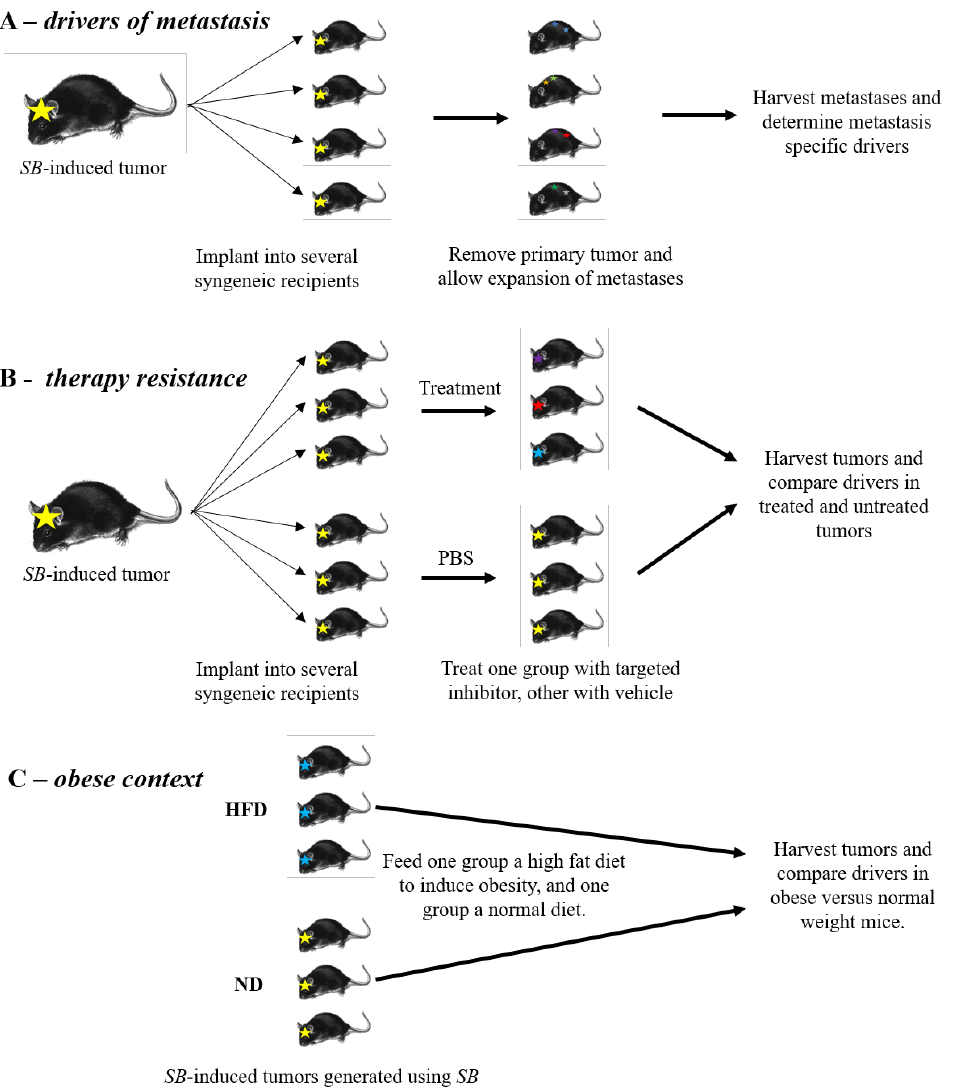
Figure 2. Future experiments for transposon insertional mutagenesis screens. ( A , B ) To identify drivers, induce tumor formation with insertional mutagenesis and implant tumors orthotopically into syngeneic recipients. ( A ) The primary tumor is expanded and removed before endpoint, allowing the metastatic lesions to expand and be harvested for driver analysis. ( B ) Implanted tumors are treated with a targeted inhibitor or left untreated and their drivers compared. ( C ) Mice undergoing mutagenesis are fed a normal or high fat diet. At endpoint all tumors are harvested and their drivers compared.